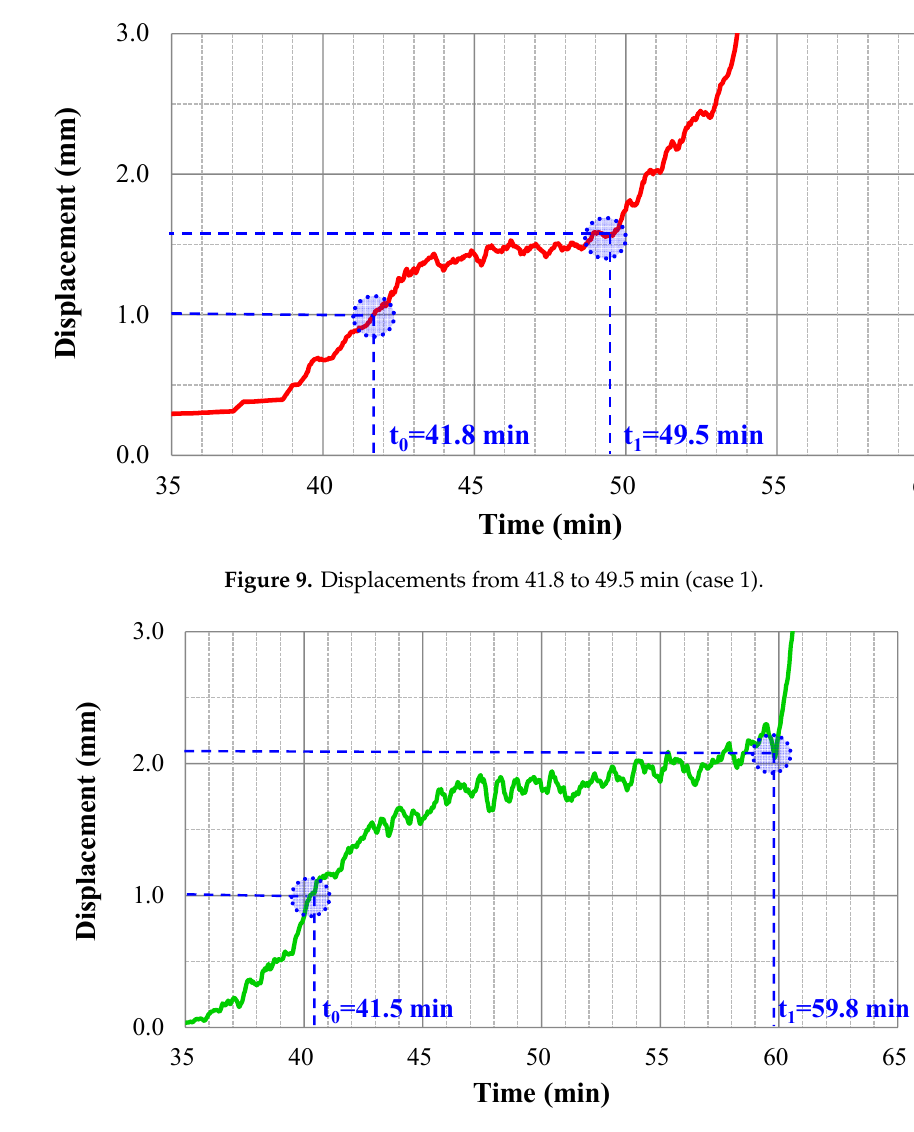
Figure 10. Displacements from 41.5 to 59.8 min (case 2).